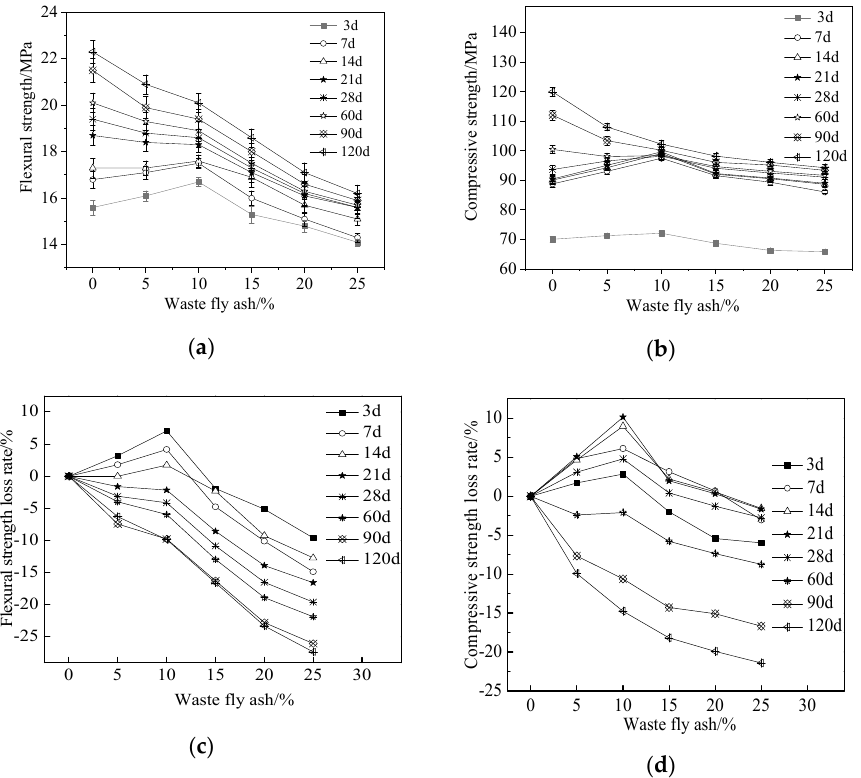
Figure 3. The mechanical strengths of RPC with WFA: ( a ) flexural strength; ( b ) compressive strength; ( c ) flexural strength loss rate; ( d ) compressive strength loss rate.